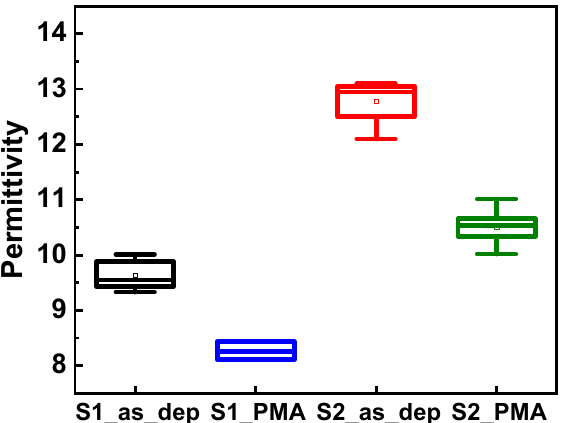
Figure 4. Permittivity of Al 2 O 3 samples under deposition conditions (O 2 plasma exposure time: 3 and 7 s) and post-metallization annealing (PMA).